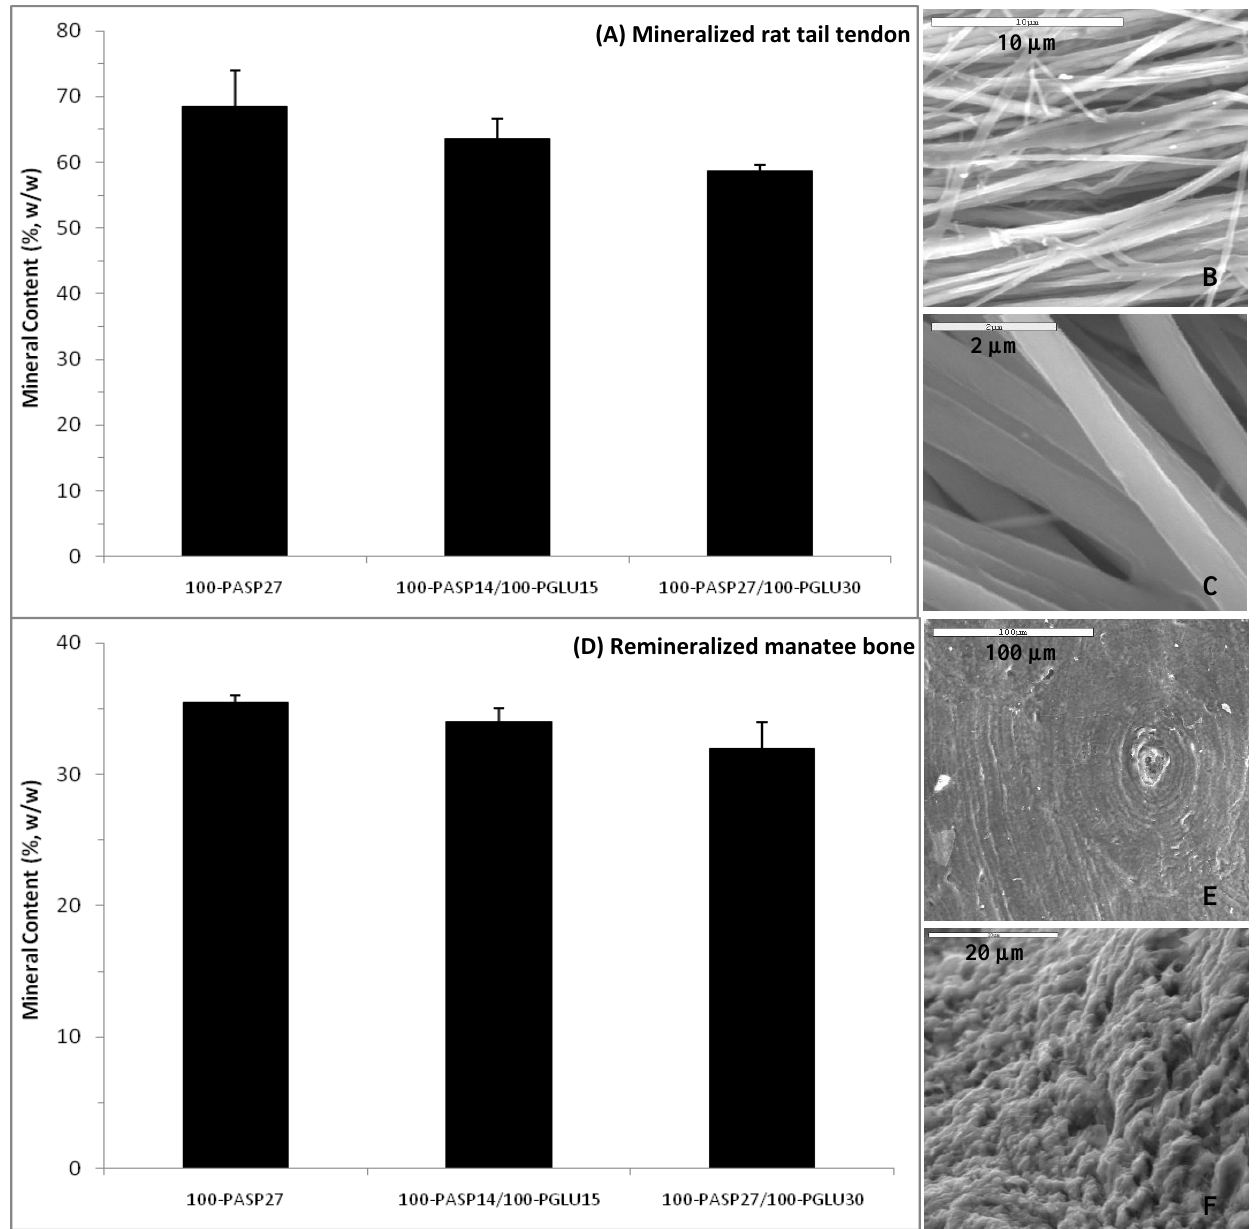
Figure 11. Mineral content of biological, dense collagen scaffolds mineralized via the PILP process. ( A ) Rat tail tendons mineralized with 100 µg/mL poly-L-aspartic acid or a combination of polyaspartic and polyglutamic acid for 7 days. SEM micrographs of tendon fibers mineralized with ( B ) 50:50 PASP14/PGLU15 and ( C ) PASP27. ( D ) Demineralized manatee bone specimens mineralized with 100 µg/mL poly-L-aspartic acid or a combination of polyaspartic and polyglutamic acid for 14 days. SEM micrographs of manatee bone remineralized with ( E ) 50:50 PASP27/PGLU30 and ( F )